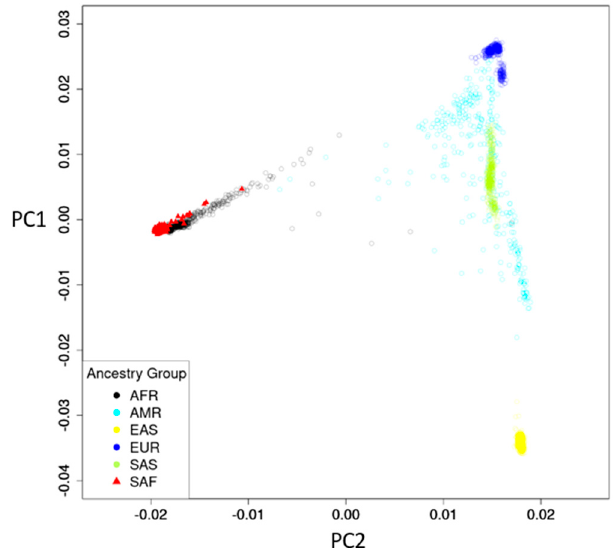
Figure 1. Ancestry map of study participants and reference panel. Reference panel of 1000 Genome project: AFR, African; AMR, American; EAS, East Asian; EUR, European; SAS, South Asian. Study participants: SAF, South African.